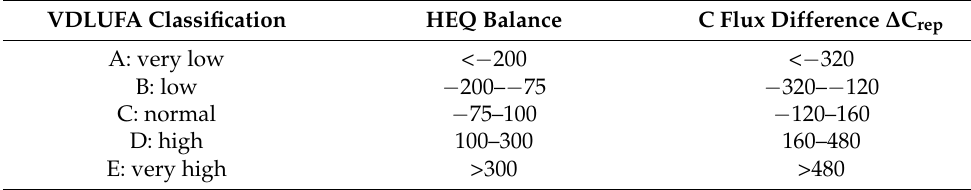
Table 2. VDLUFA classification and corresponding ranges of HEQ and C rep (C rep = 1.6 ×